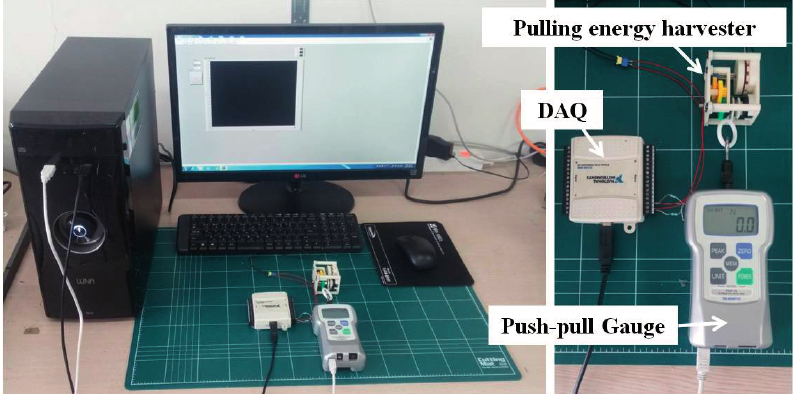
Figure 7. Experimental set-up for the simultaneous measurement of mechanical input and electric output